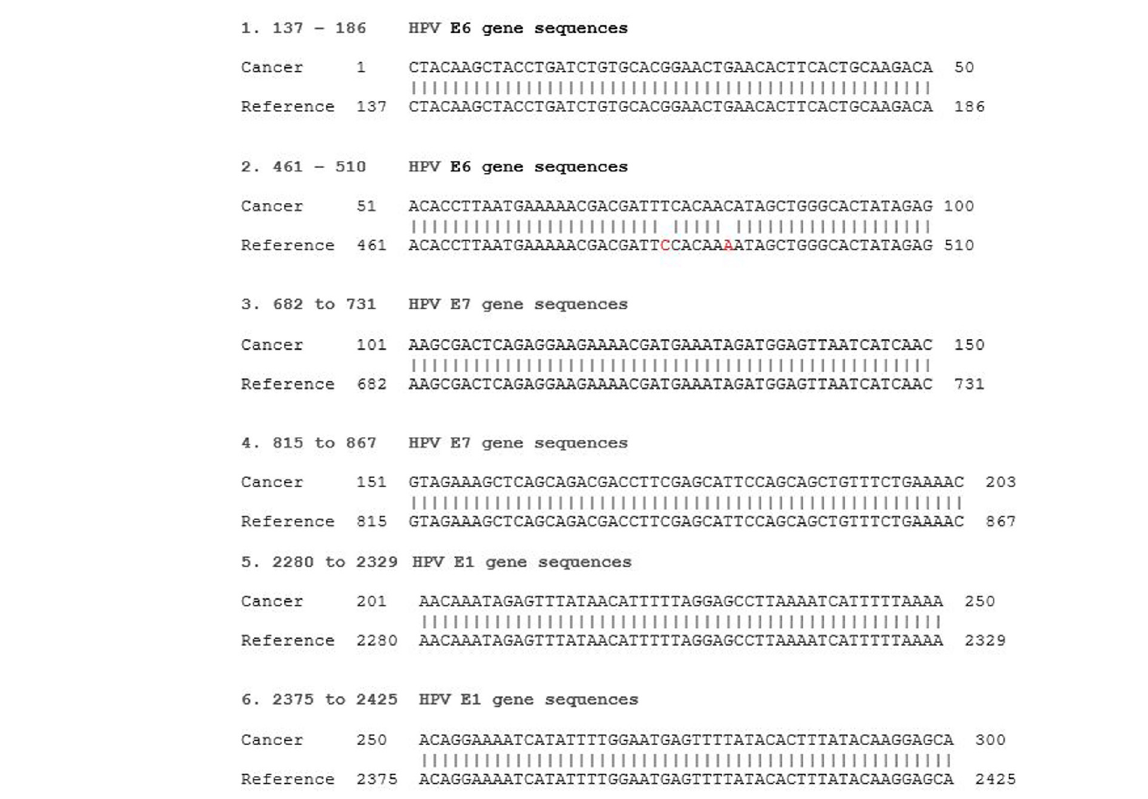
FigUre 1 | hPV type 18 e6 and e7 rna gene sequence identified in an invasive breast cancer specimen by next generation sequencing . Invasive breast cancer specimen 36 TCGAAR-A24P-01A-11R-A169-07 (see Table S1 in Supplementary Material) sequence compared to reference HPV 18 KC470228. E6 gene sequences reference 105-581, E7 590-907, E1 914-2887. The two point mutations at reference 484 and 490 have been observed in reference HPV 18